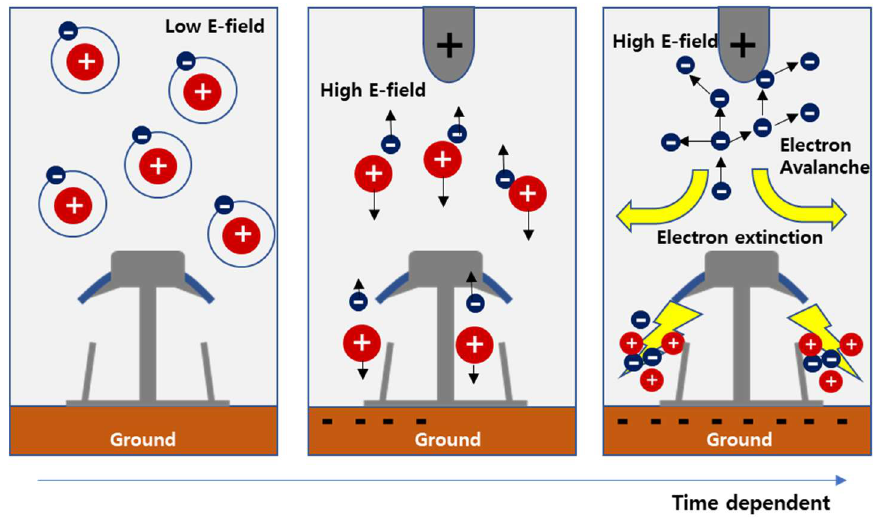
Figure 5. Schematic of molecular ionization by external high electric field.